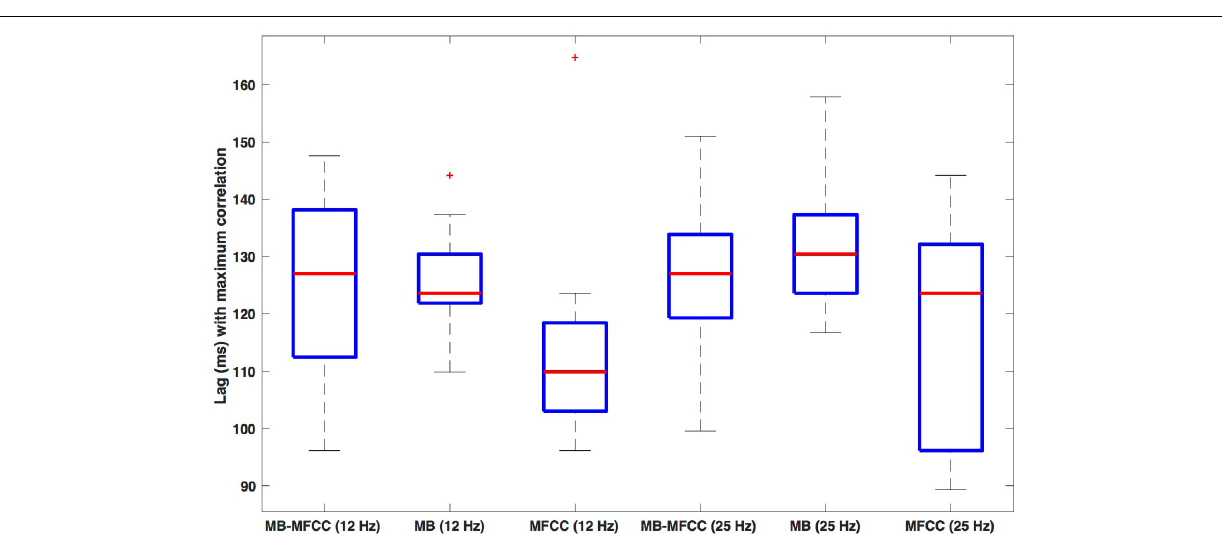
FIGURE 8 | Box plots of the lag value (in ms) at which secondary maxima of correlation function are found. Lags are the average of the absolute values of the negative and positive lags. The three leftmost plots show (respectively): the lags for correlation of MBEAM with MFCC, the autocorrelation of MBEAM, and the autocorrelation of MFCC, all for the 12 Hz filtering condition. The three rightmost plots show the same three signal correlations for the 25 Hz filtering